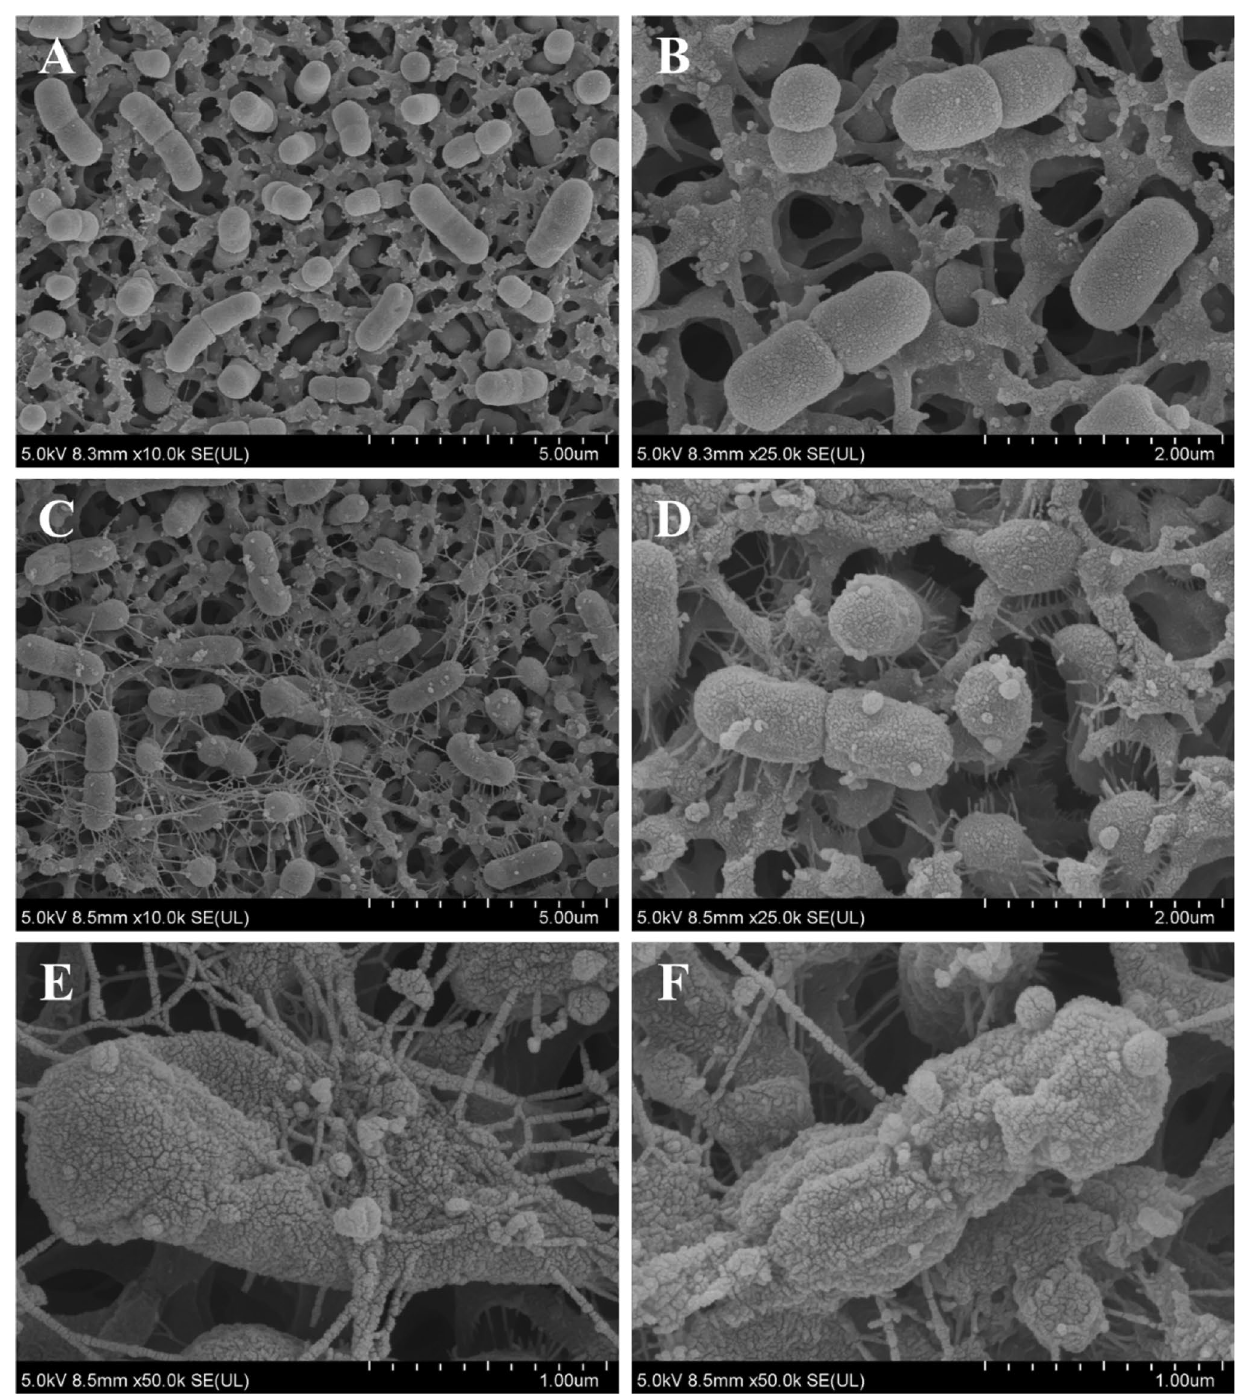
Figure 6. Scanning electron microscopic micrographs of A. baumannii ATCC 19,606 treated with D-AP19. Untreated bacterial cells ( A ), ( B ) and treated with half MIC of D-AP19 for 15 min ( C )–( F